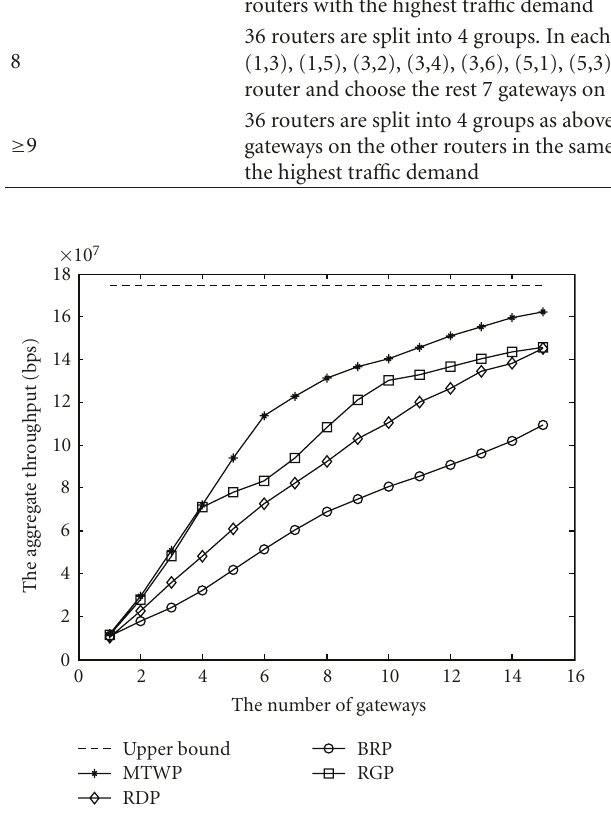
Figure 12: The comparison of the aggregate throughput with unevenly distributed mesh clients.